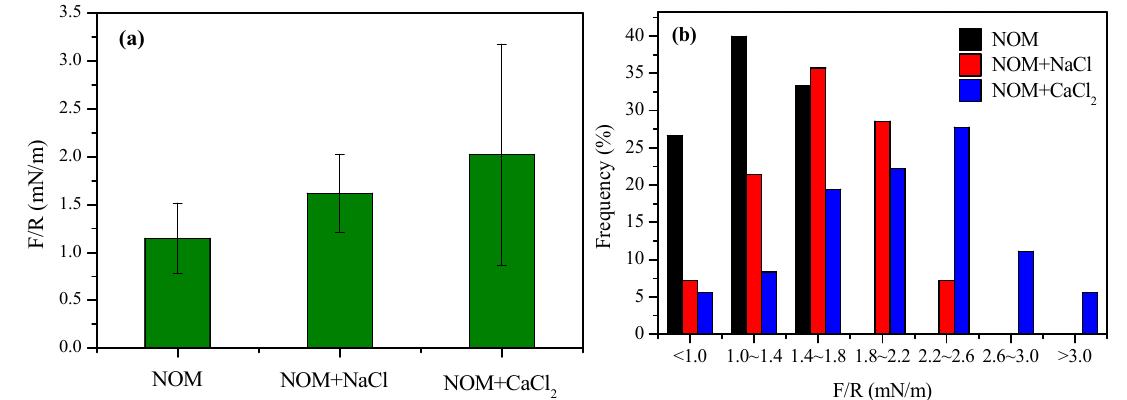
Figure 2. ( a ) Interfacial interactions between the reconstituted NOM and membrane surface in the absence or presence of cations: Interacting adhesion force; ( b ) Distribution of adhesion force. Error bars indicate the standard error of 160 measurements.